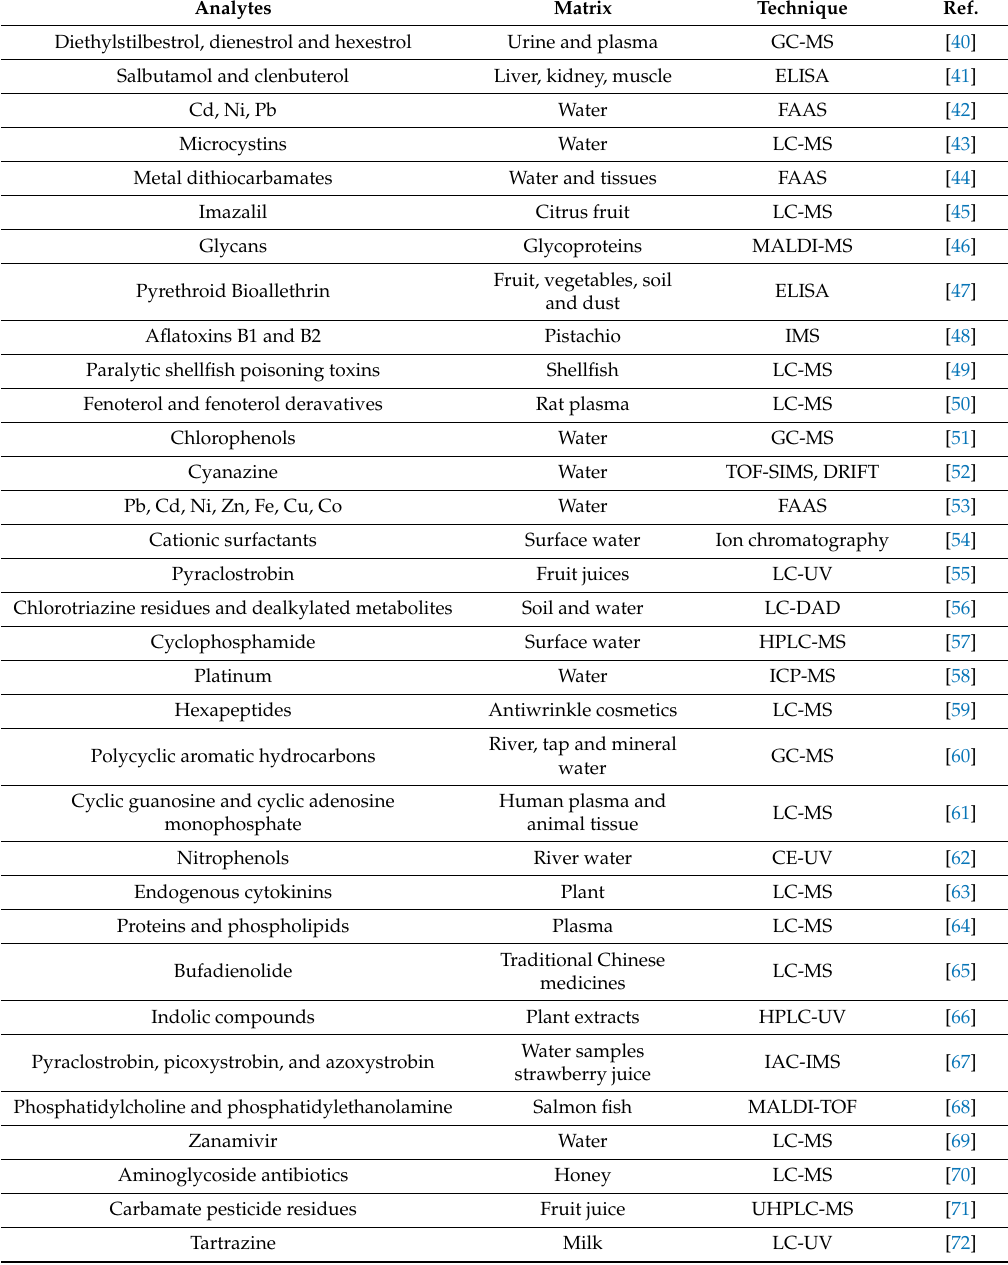
Table 1. Examples of solid phase extraction (SPE) applications in the analysis of various